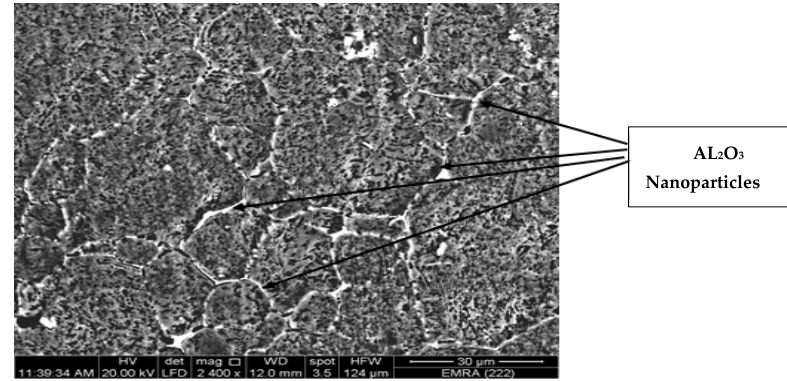
Figure 11. Al 2 O 3 nanoparticle distribution between the base alloy grain boundaries.